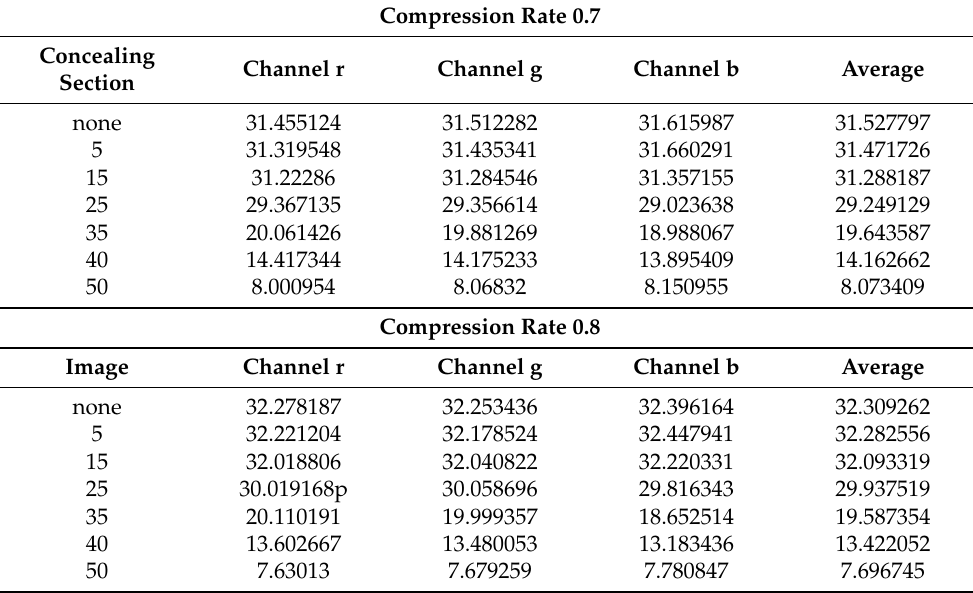
Table 3. PSNR values with the impact of white Gaussian noise (Unit: